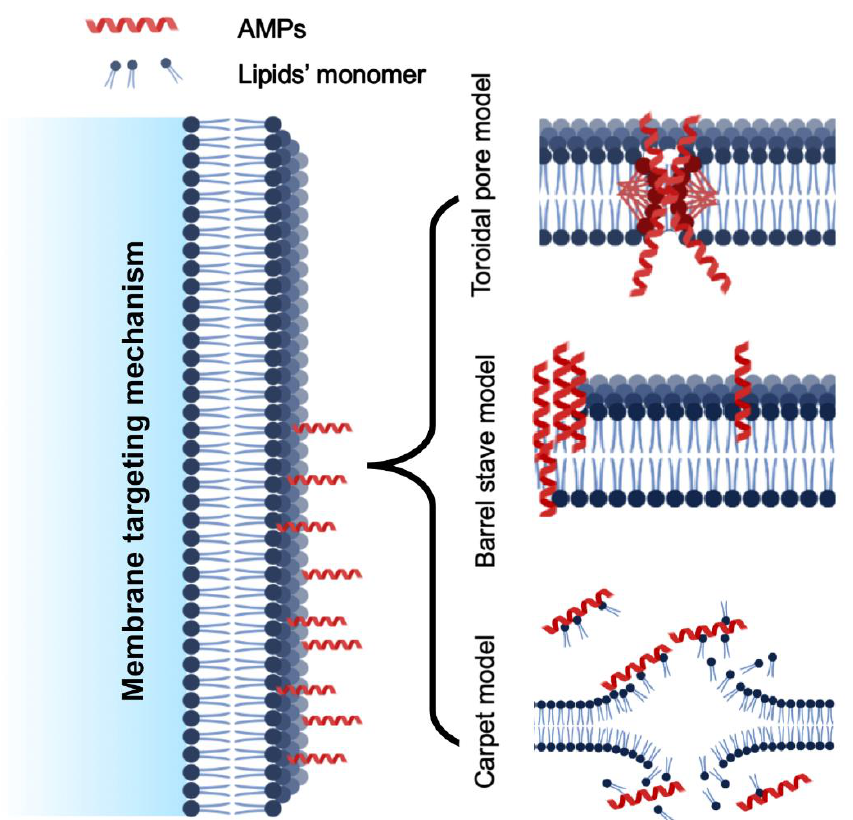
Figure 4. Various models of cell membrane targeting mechanism of